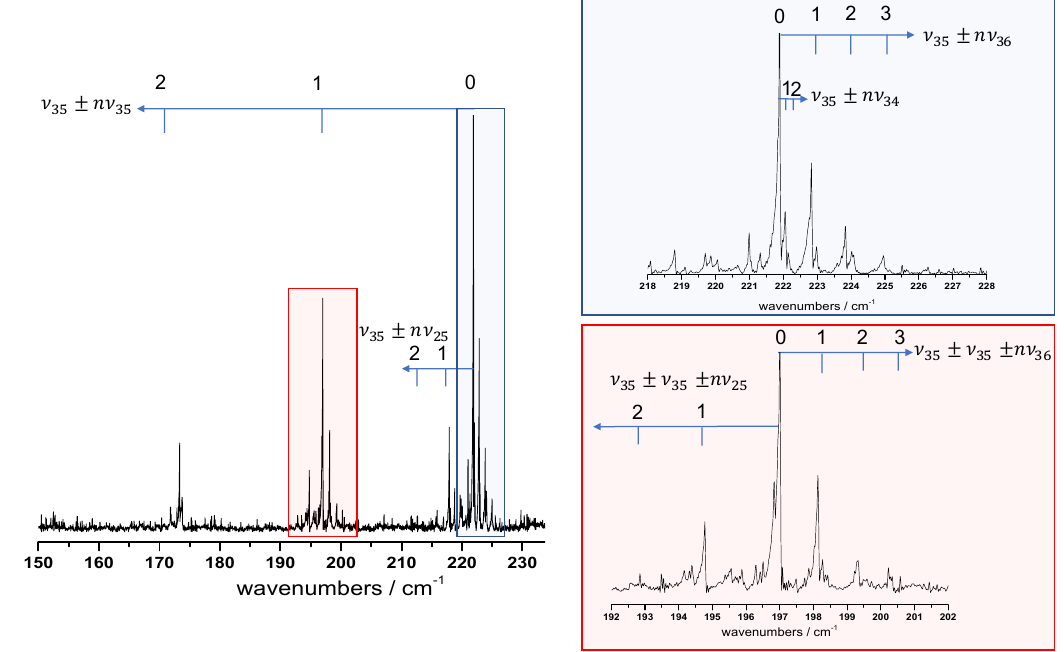
Figure 4. Hot band assignment proposition around the ν 35 free -OH torsional band at middle resolution (10 − 2 cm − 1 ). The assigned hot band progressions ν i ± n ν j and ν i ± ν i ± n ν j are marked with blue arrows. Two spectral zones are zoomed: the blue panel shows the hot band sequence red shifted from the ν 35 fundamental vibrational centre; the red panel highlights the hot band substructure around the | 2 v 35 (cid:105) ← | v 35 (cid:105) vibrational